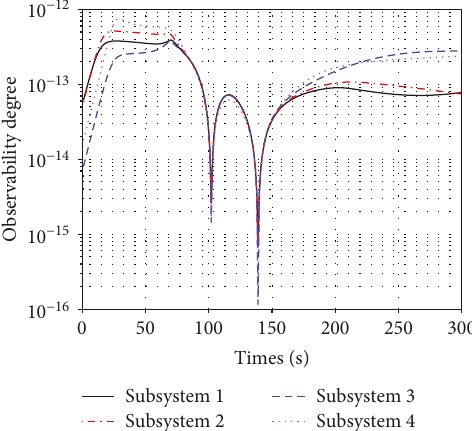
Figure 3: Observability degree of the navigation